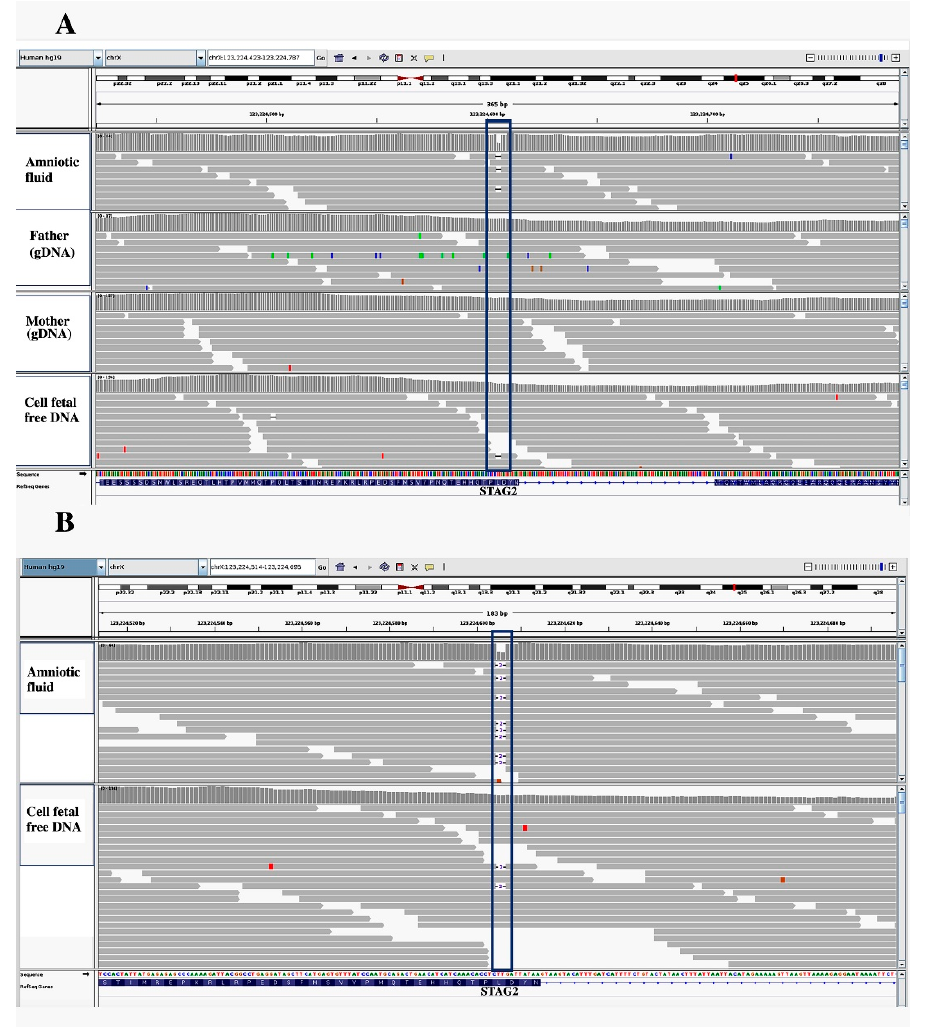
Figure 4. IGV representation of STAG2 sequencing in cff-DNA and gDNA from amniotic fluid, father, and mother. the gray lines show the reads produced and aligned with the reference genome (hg19). ( A ) the STAG2 heterozygous frameshift variant c. 3458_3459delTT was present in the cff-DNA and in the amniotic fluid but not in the parents. The blue boxes highlight the amniotic fluid and cff-DNA, the horizontal black lines represent the two base deletions as clearly indicated in the enlargement below. ( B ) Zoom of the STAG2 variant in the amniotic fluid and cff-DNA; in amniotic fluid, the variant is more represented than in cff-DNA in which the dilution of the variant by maternal DNA makes its recognition less immediate.